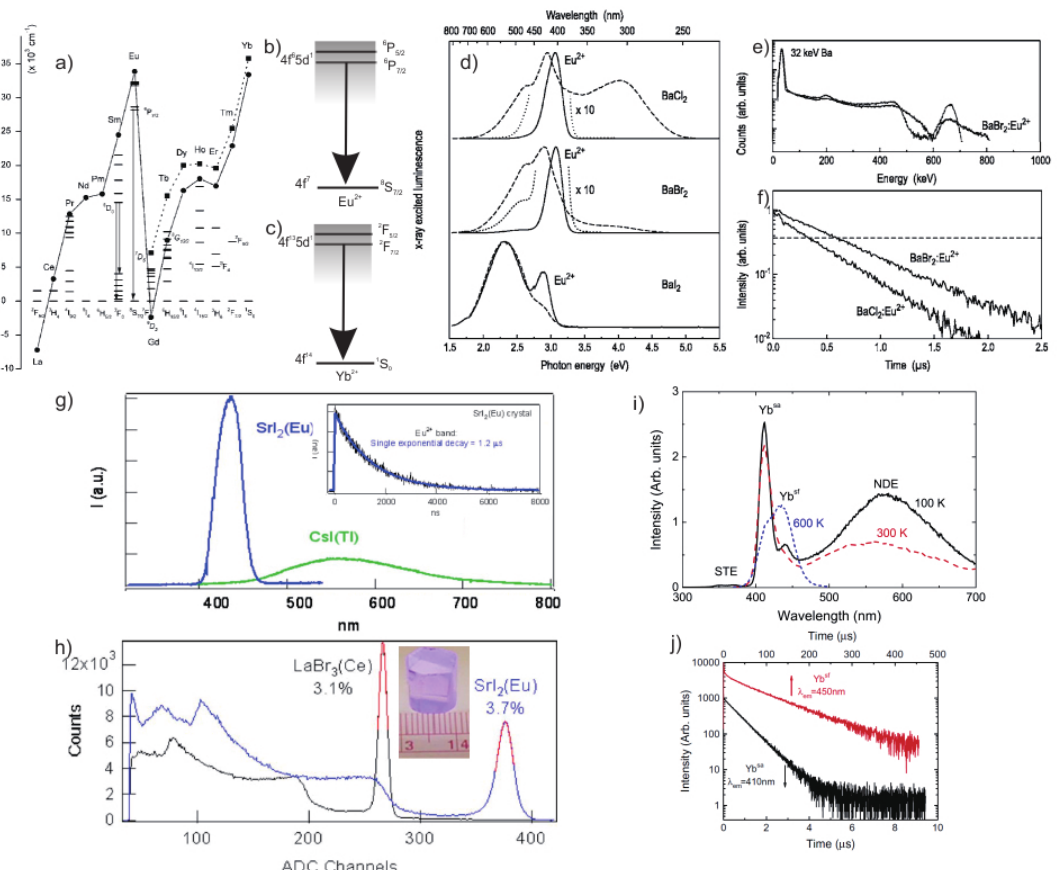
Figure 4. Divalent lanthanide-doped scintillators: ( a ) 4 f n energy level scheme of the free divalent lanthanides. The first fd level is connected with the full line. ( b , c ) Singlet 5d → 4f allowed transition of Eu 2 + and Yb 2 + , respectively. ( d ) Normalized X-ray excited luminescence spectra of undoped (dashed curves) and Eu 2 + doped (solid curves) BaX 2 ( X = Br , Cl , I ). Parts of the spectra of the Eu 2 + doped samples (dotted curves) are blown up ten times as indicated. All spectra were recorded at RT. ( e ) Pulse height spectrum of a 137 Cs source measured with undoped and Eu 2 + doped BaBr 2 crystals. ( f ) Scintillation decay curves for Eu 2 + doped BaX 2 ( X = Br , Cl ) crystals. ( g ) Beta-excited emission spectrum from Eu 2 + doped SrI 2 compared to that of CsI : Tl . The inset exhibits time-resolved emission decays acquired by excitation with 30 ns laser pulses at 266 nm. ( h ) Pulse-height spectra acquired of a SrI 2 : Eu 2 + crystal yielding an energy resolution of 3.7% at 662 keV. In the inset, a photo from SrI 2 : Eu 2 + crystal under 254 nm excitation. ( i ) X-ray excited emission spectra of SrI 2 : 0.5% Yb 2 + measured at 100, 295, and 600 K. The 410 nm and 450 nm bands are spin-allowed ( Yb sa ) and spin-forbidden ( Yb sf ) Yb 2 + 5d → 4f transitions, respectively. ( j ) Time-resolved emission at 295 K of black and red curves from SrI 2 : 0.5% Yb 2 + recorded under 340 nm excitation by monitoring the Yb sa and Yb sf emission, respectively. Figures reproduced from ( a ) Dorenbos, P., J. Phys. Condens. Matter 2003 , 15,